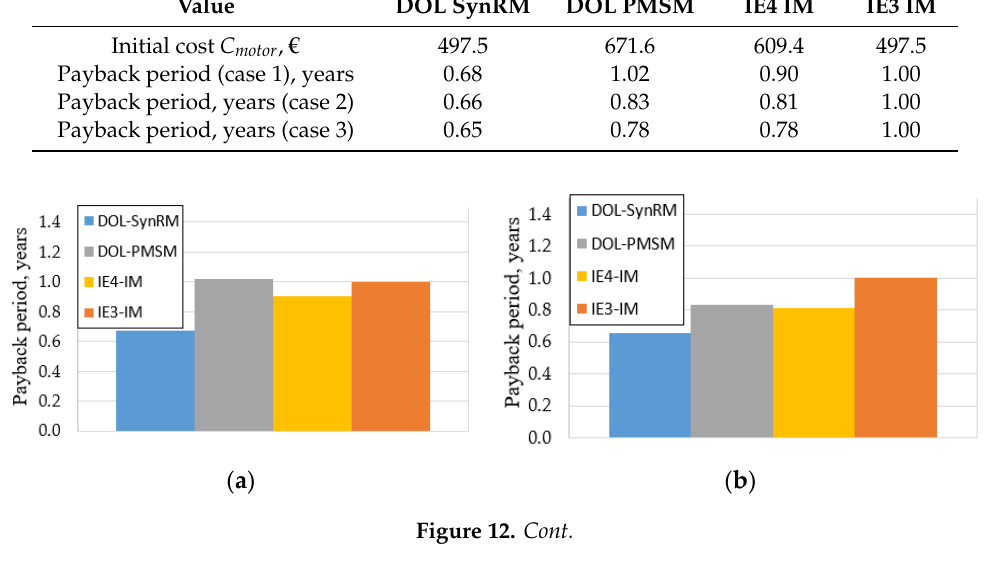
Table 11. Results of the payback period (the case of replacing the motor in an exploiting pump unit). Value DOL SynRM DOL PMSM